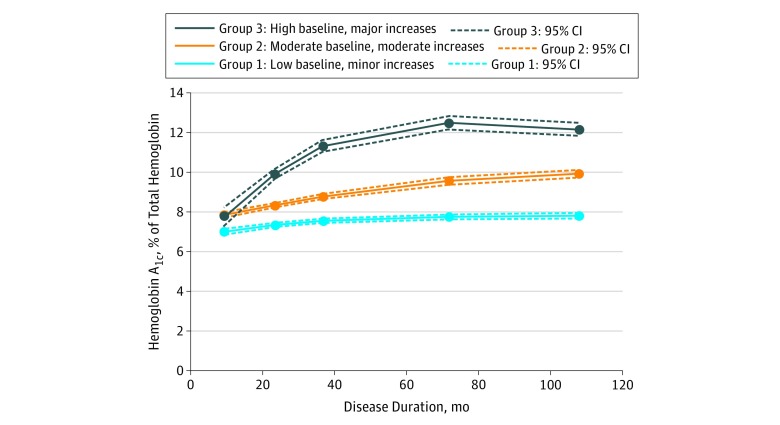
Trajectories of Hemoglobin A1c in 1313 Patients With Type 1 Diabetes in the SEARCH for Diabetes in Youth Study Group-based trajectory modeling identified 3 distinct hemoglobin A1c trajectories over a mean type 1 diabetes duration of 108 months. To convert hemoglobin A1c to proportion of total hemoglobin, multiply by 0.01.